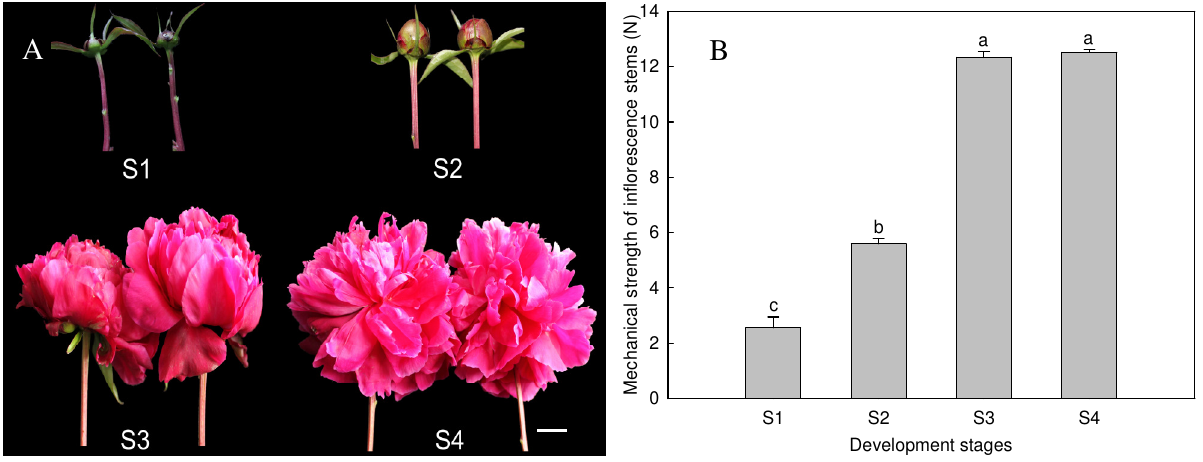
Figure 1. Plant phenotype and mechanical strength of inflorescence stem. ( A ) Plant phenotype of four development stages; ( B ) Mechanical strength of inflorescence stem. Different letters including a, b and c indicate significant difference at the 0.05 level. Bar = 2